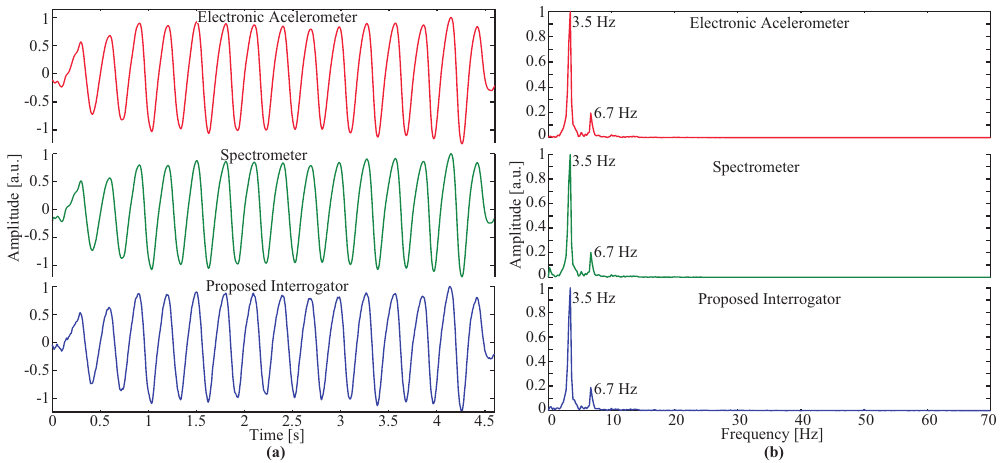
Figure 4. Response of quasi-periodic oscillation: ( a ) Temporal result; ( b ) fast Fourier transform (FFT) of the temporal